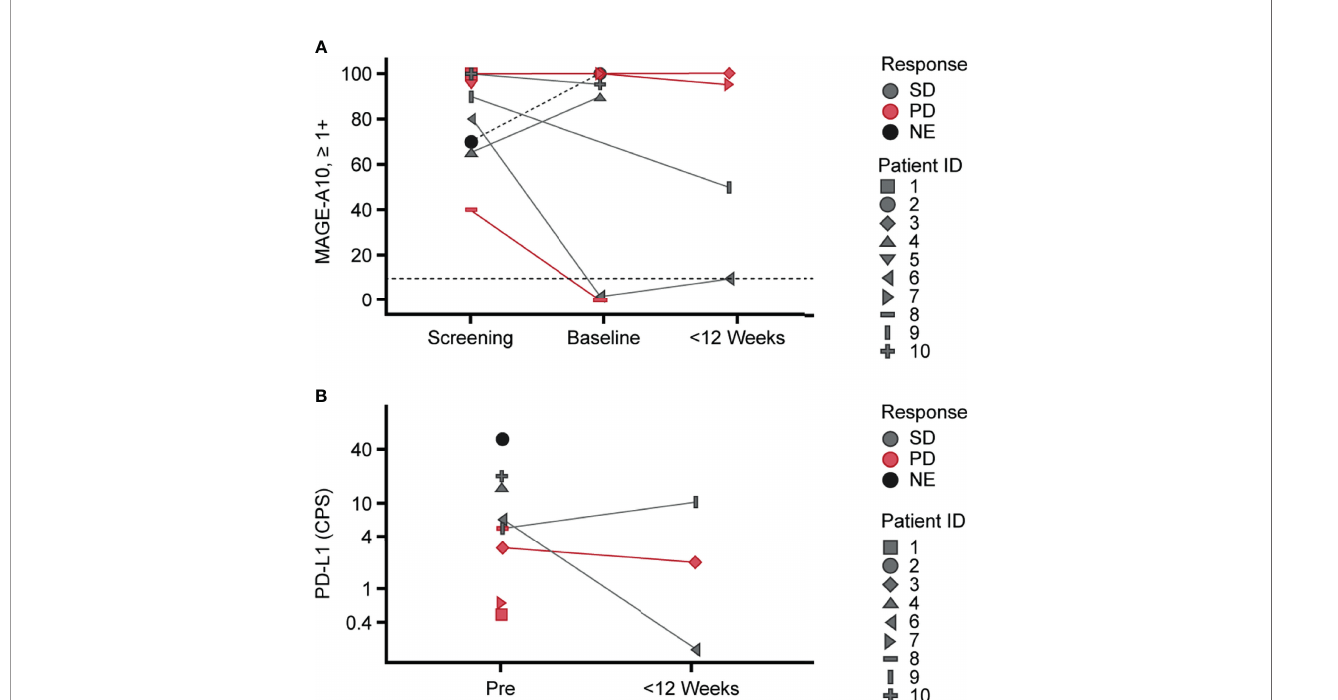
FIGURE 3 | Variability of MAGE-A10 and PD-L1 expression in tumor tissue across the study patients. Pre-infusion (screening and baseline) and post-infusion biopsies collected within 12 weeks after infusion were used for (A) MAGE-A10 expression and (B) PD-L1 expression evaluation. (A) MAGE-A10 expression was assessed by MAGE-A10 immunohistochemical staining and plotted as percentage of tumor cells with 1+, 2+ and 3+ intensities. Horizontal lines designate the cut-off of 10% of tumor with ≥ 1+ intensity of staining. (B) PD-L1 expression was assessed using PD-L1 IHC 22C3 pharmDx assay and plotted in terms of CPS. (A, B) Data points are colored by response. Patient IDs are indicated by shape. CPS, Combined Positive Score; MAGE, melanoma-associated antigen; NE, not evaluable; PD, progressive disease; PD-L1, programmed death ligand 1; Pre, pre-infusion; SD, stable